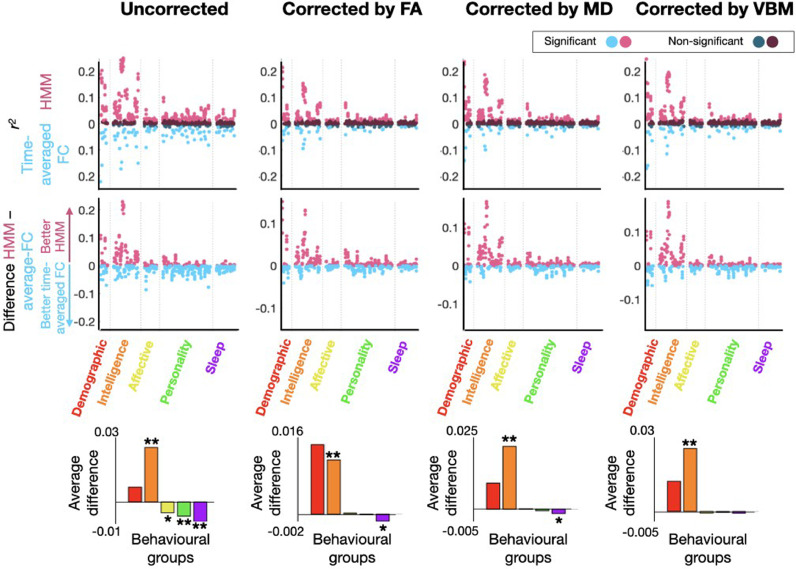
Explained variance r2 (in terms of squared Pearson's correlation) for the prediction of behavioural traits using the time-averaged-FC-DM and the HMM-DMs. In the top panels, r2 values (upwards for the HMM and downwards for the time-averaged representation; lighter colours represent statistically significant predictions and darker non-significant; Bonferroni-corrected Student's t-tests); in the middle panels, difference between the HMM and the time-average FC representations; in the bottom panels, the average differences aggregated by behavioural group (* and ** reflect statistical significance for significance levels of 0.05 and 0.01; permutation testing).